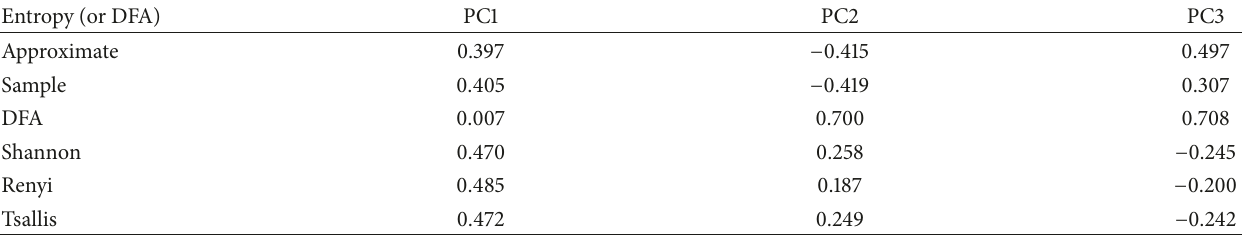
Table 8: The relevant Principal Component Analysis for five entropies and DFA of 31 traffic noise exposure subjects. Entropy (or DFA) PC1 PC2 PC3 Approximate 0.397 0.497